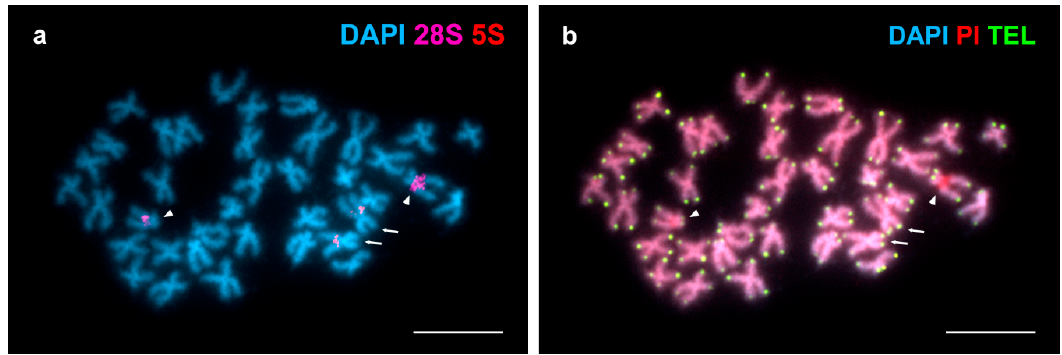
Figure 2. Mapping of telomeric sequences to Arctica islandica chromosomes. ( a ) DAPI stained metaphase plate hybridized with major (28S, magenta) and minor (5S, red) rDNA probes. ( b ) The same plate hybridized with a telomeric (TEL) (C 3 TA 2 ) 3 PNA probe (TEL, green) and counterstained with DAPI/PI. Note that the short arms of chromosome pair 2 (arrows) display brighter telomeric signals than their long arms whereas the differences in brightness affect homologous chromosomes in pair 12 (arrowheads). Scale bars, 5 µ m. Table 1. Relative lengths and centromeric indices of Arctica islandica